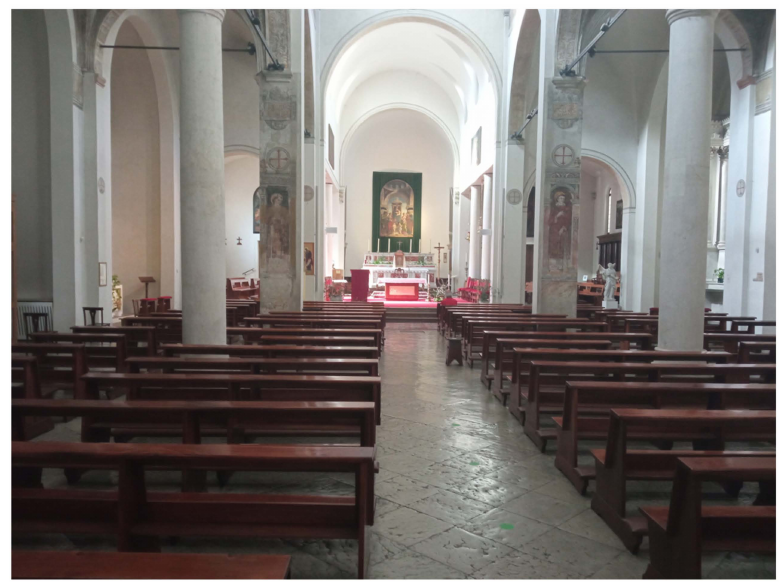
Figure 2. The internal view of the current configuration of the Conegliano Dome.